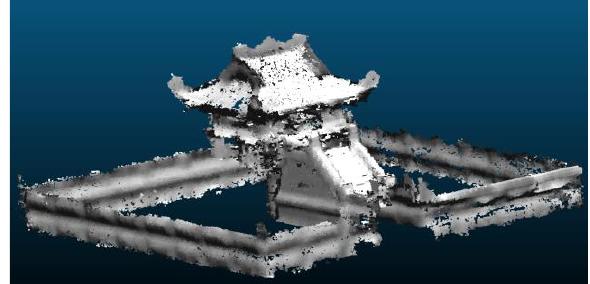
Figure 8. “One Pilla” pagoda 3D model